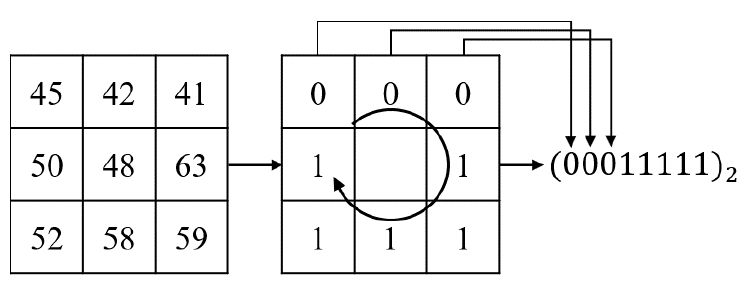
Figure 3. Example of encoding a LBP feature.